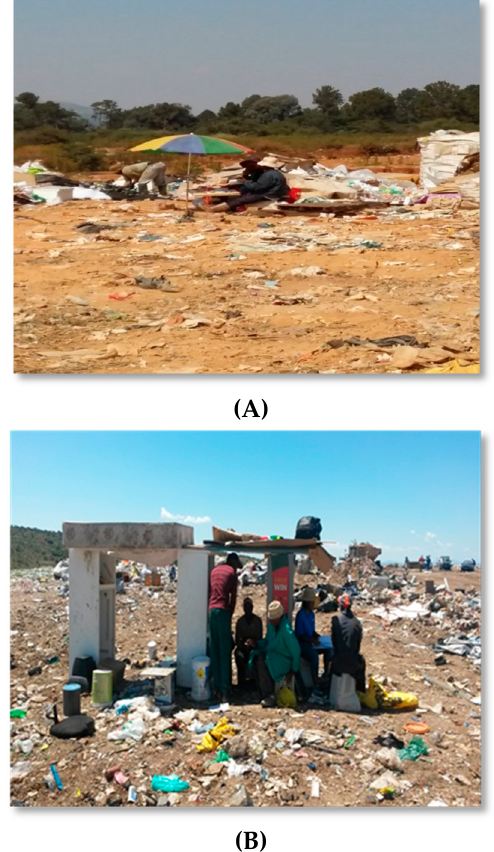
Figure 8. ( A,B ) Di ff erent types of shelters on landfills. Source: